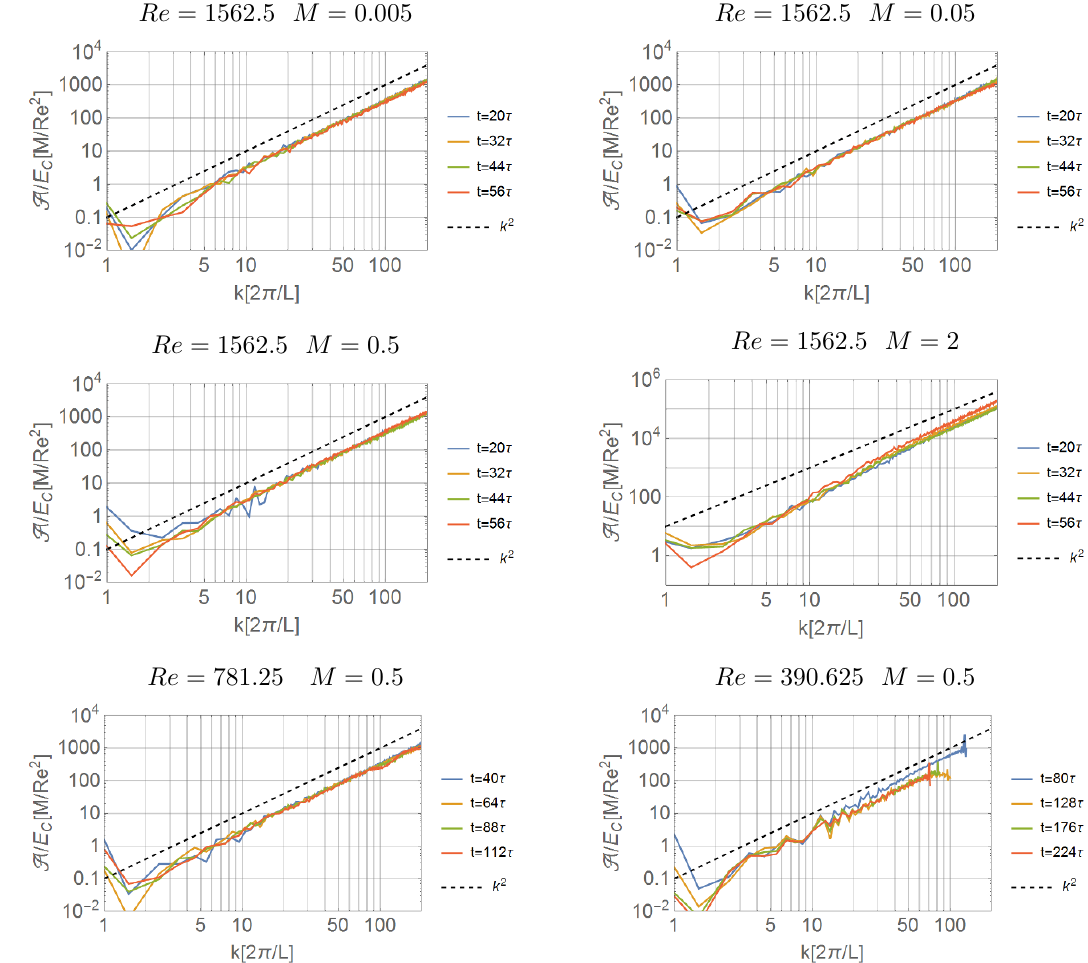
Figure 18 . The ratio A ( t; k ) =E C ( t; k ) for two dimensional turbulent (cid:13)ows at intermediate times. The dashed line scales like k 2 . The ratio A =E C deviates from the expected k 2 scaling for M = 2.